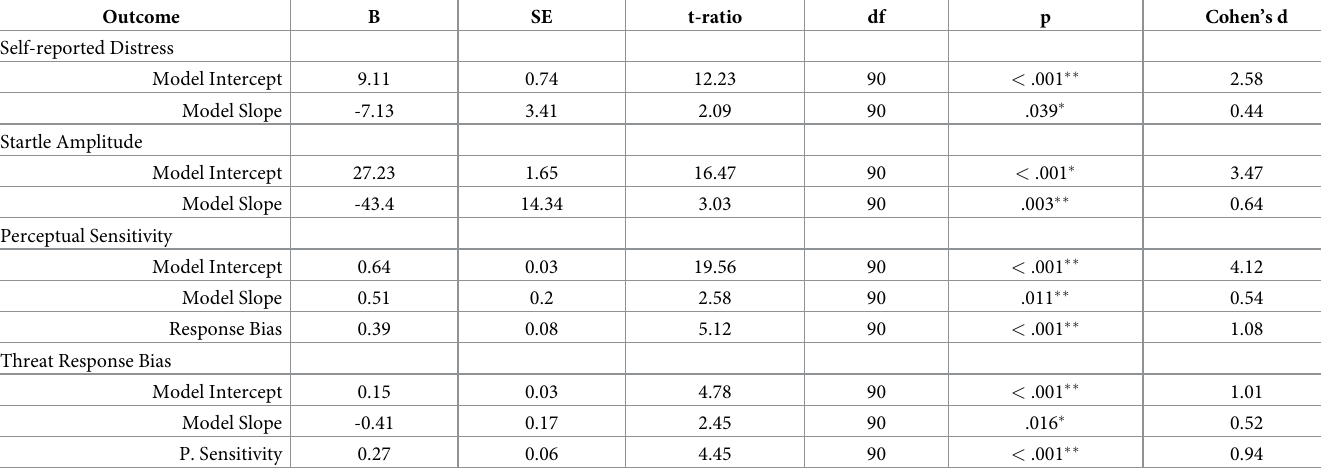
Table 3. Changes in extent of recent marathon-related coverage predicts distress, startle reactivity, perceptual sensitivity, and shooting